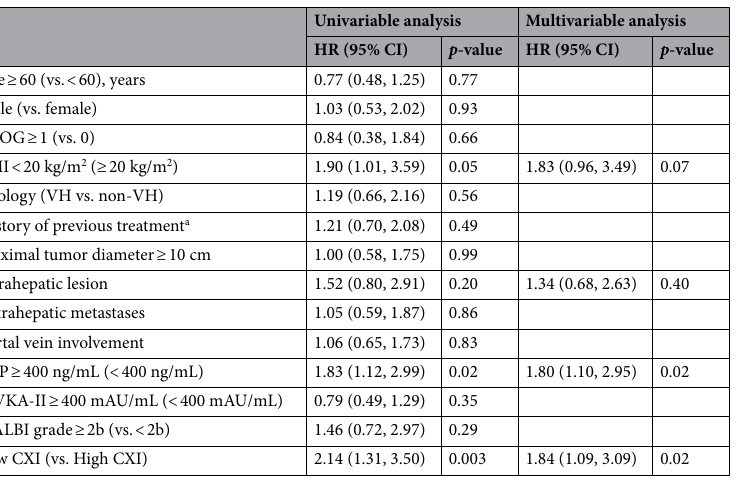
Table 5. Multivariable Cox regression analysis for progression-free survival. HR: hazard ratio; CI: confidence interval; ECOG: Eastern Cooperative Oncology Group; BMI: body mass index; VH: viral hepatitis; BCLC: Barcelona Clinic Liver Cancer; AFP: alpha-fetoprotein; PIVKA-II: Protein Induced by Vitamin K Absence or Antagonist-II; mALBI grade: modified ALBI grade; CXI: cancer cachexia index. a Defined treatment history of resection, liver transplantation, radiofrequency ablation, transarterial chemoembolization, transarterial radioembolization and radiation